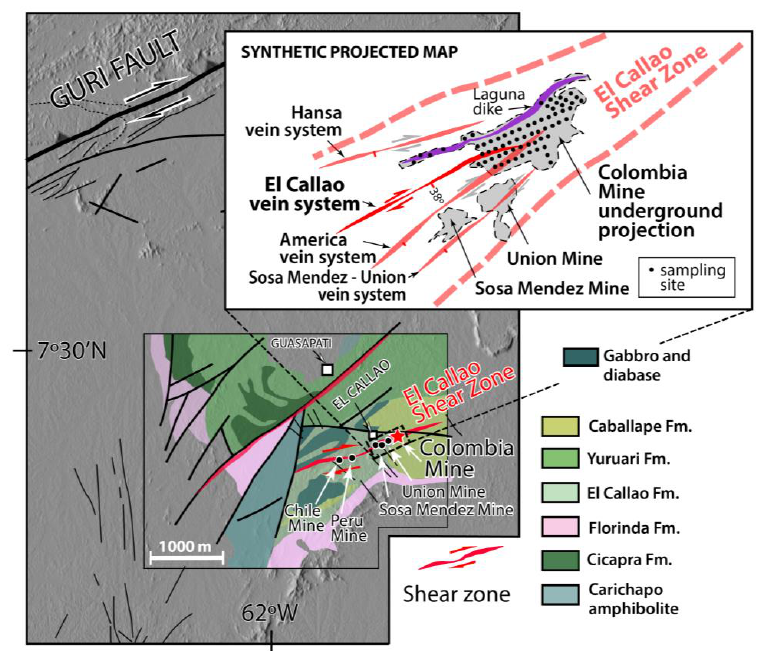
Figure 2. Simplified geology of the El Callao mining district (modified after Velásquez et al. [2]) showing the localization of the El Callao shear zone and the Colombia Mine (study area). The sketch map in the inset represents a projection of the underground observations at the Colombia mine, locating the sampling